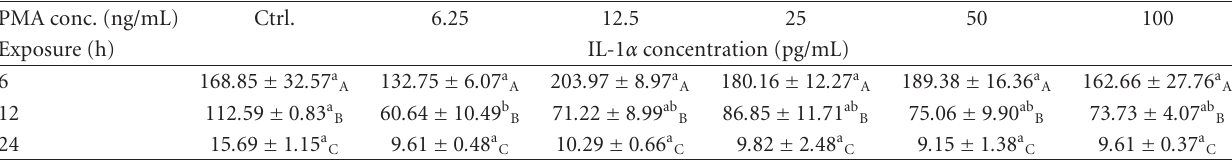
Cells were seeded at a density of 15000 cells/well. Values represent the mean ± standard deviation of four replicates. Letters in superscript (row) indicate significant di ff erent between control and PMA concentrations; letters in subscript (column) indicate significant di ff erence between incubation periods. Values